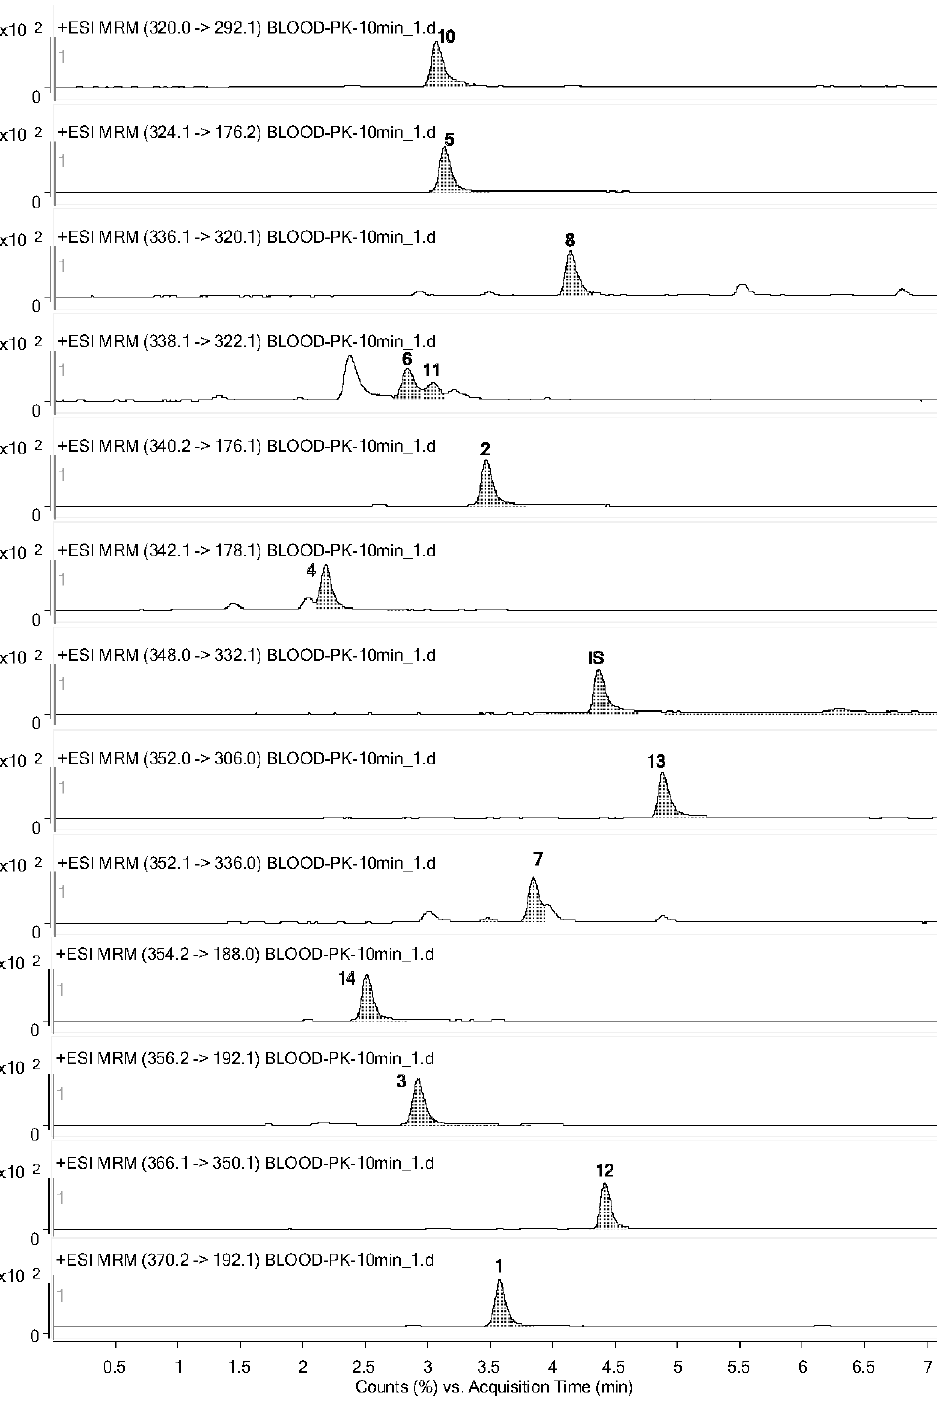
Figure 2. Representative MRM chromatograms of plasma samples at 10 min following oral administration of Corydalis yanhusuo extract.